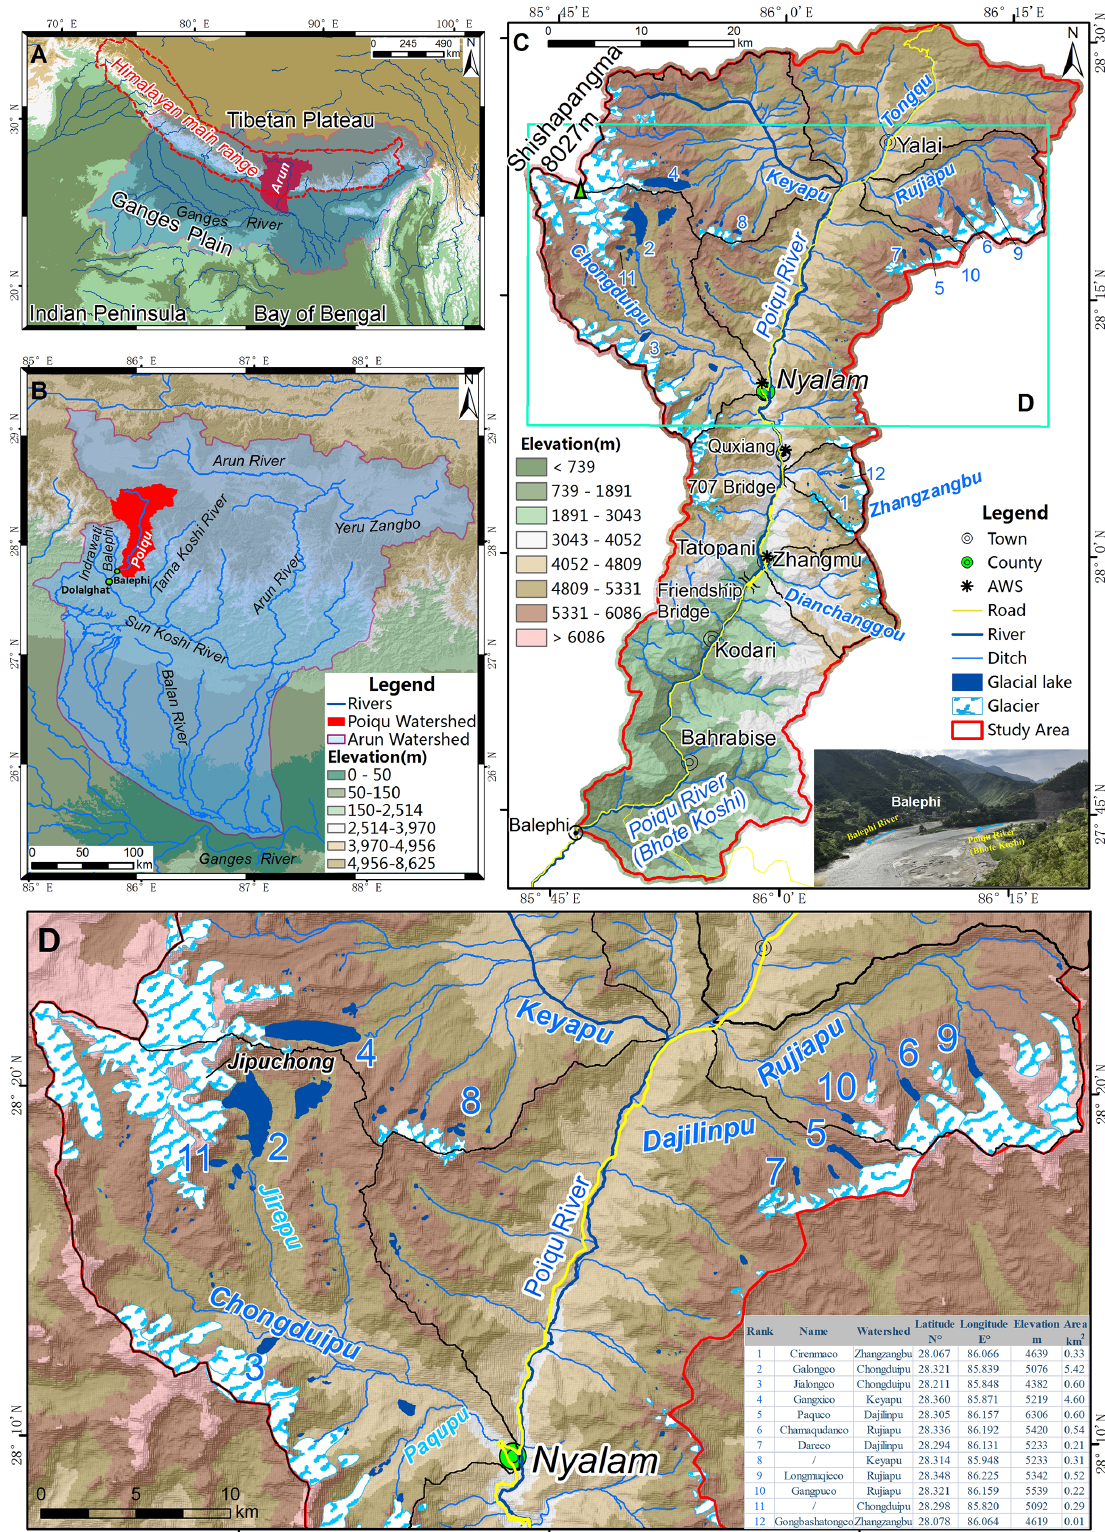
Figure 1. The Poiqu River basin in the central